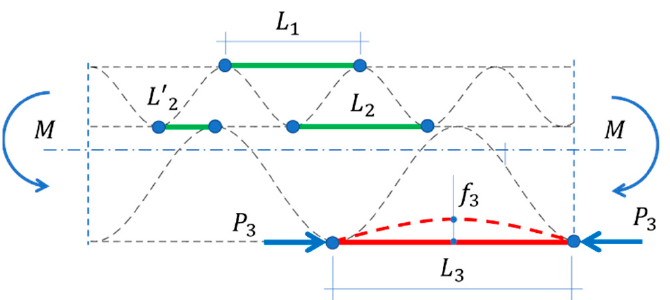
Figure 5. Compressed and stretched segments of a corrugated board cross-section during bending.